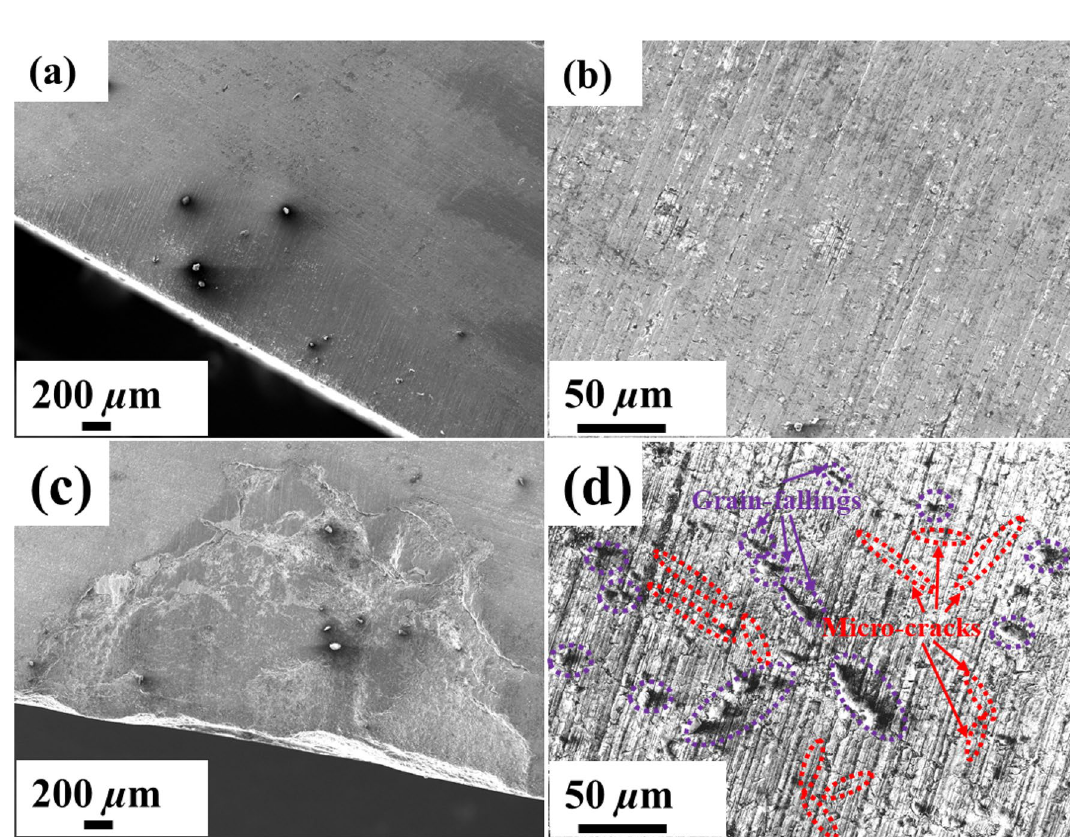
Figure 4. Morphology of Wear flat Surfaces. SEM image of the wear surface for the cutting edges of CFPDC sample ( a , b ) and commercial PDC sample ( c , d ) with a cutting length of 1260 m. Micro-cracks are marked with red circles while grain-fallings are marked with purple circles in ( d